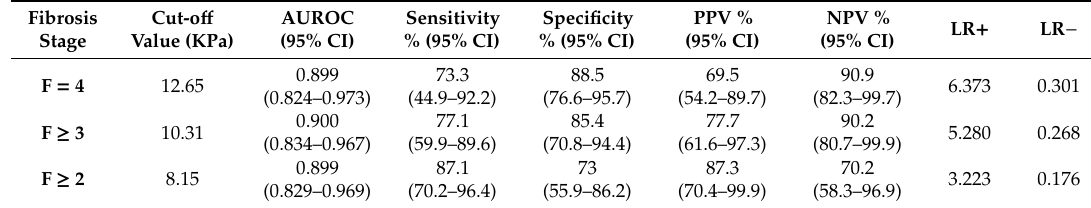
Table 3. Diagnostic performance of 2D-SWE (ElastQ) in the overall